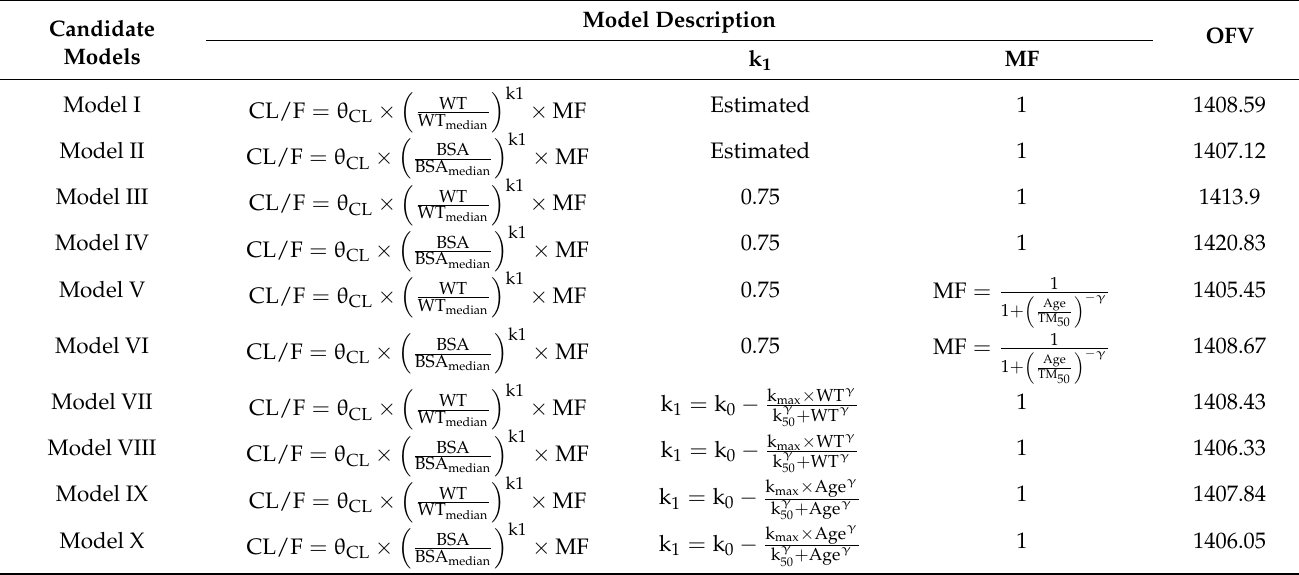
Table 2. Ten candidate models of parameter estimates for